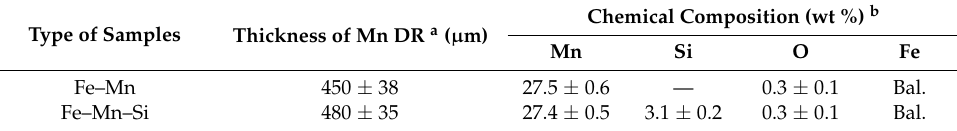
Table 1. Thickness of Mn depletion region and average chemical composition of the sintered Fe–Mn-based compacts at 1200 ◦ C for 3 h.